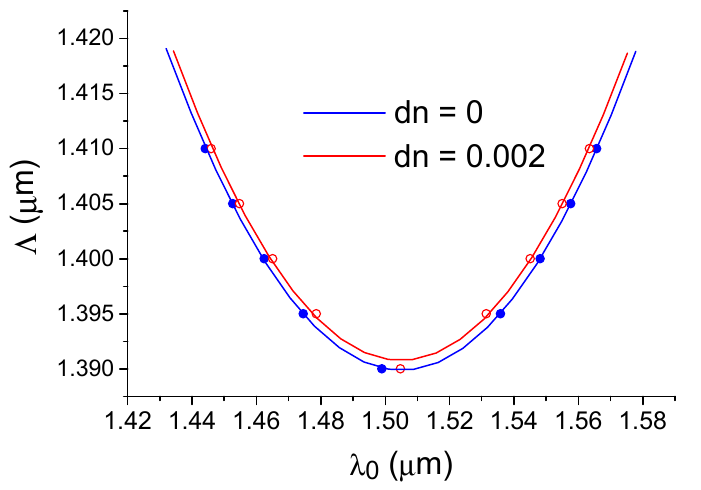
Figure 5. Dependence on the optical wavelength for the transmitted power (T) of the fundamental mode of a silicon waveguide (h = 0.25 µm, w = 0.55 µm) surrounded by water and for water with a small change (dn = 0.002) in the refractive index. Calculation by the 3D FDTD method.